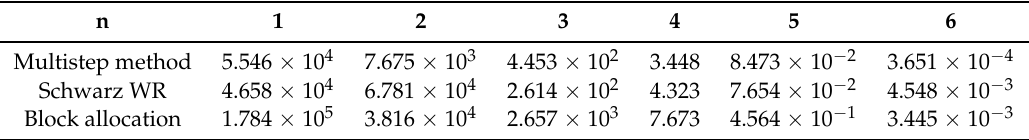
Table 2. The errors between the three methods and the Euler method on the